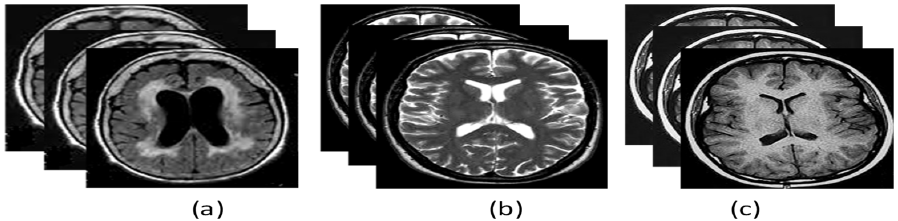
Figure 3. Brain axial MRI (T1 and T2 weighted) data for ( a ) Alzheimer’s Disease, ( b ) Mild Cognitive